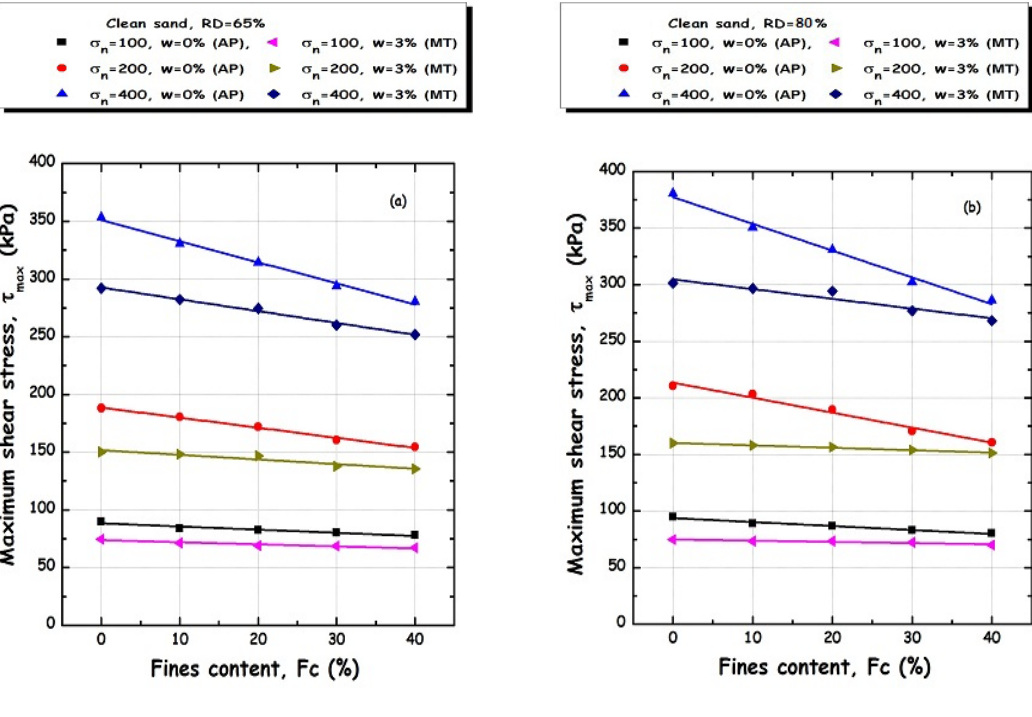
Figure 22: Effect of depositional method on the mechanical behaviour of clean sand: (a) RD = 65%, (b) RD = 80%.